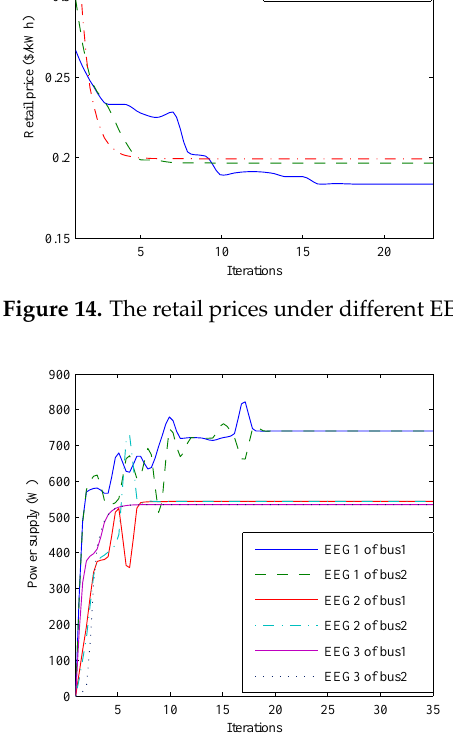
Figure 15. The power supply under different